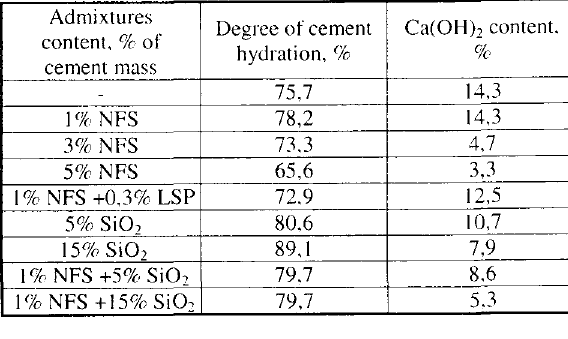
apparatus. For hardened cement paste properties testing